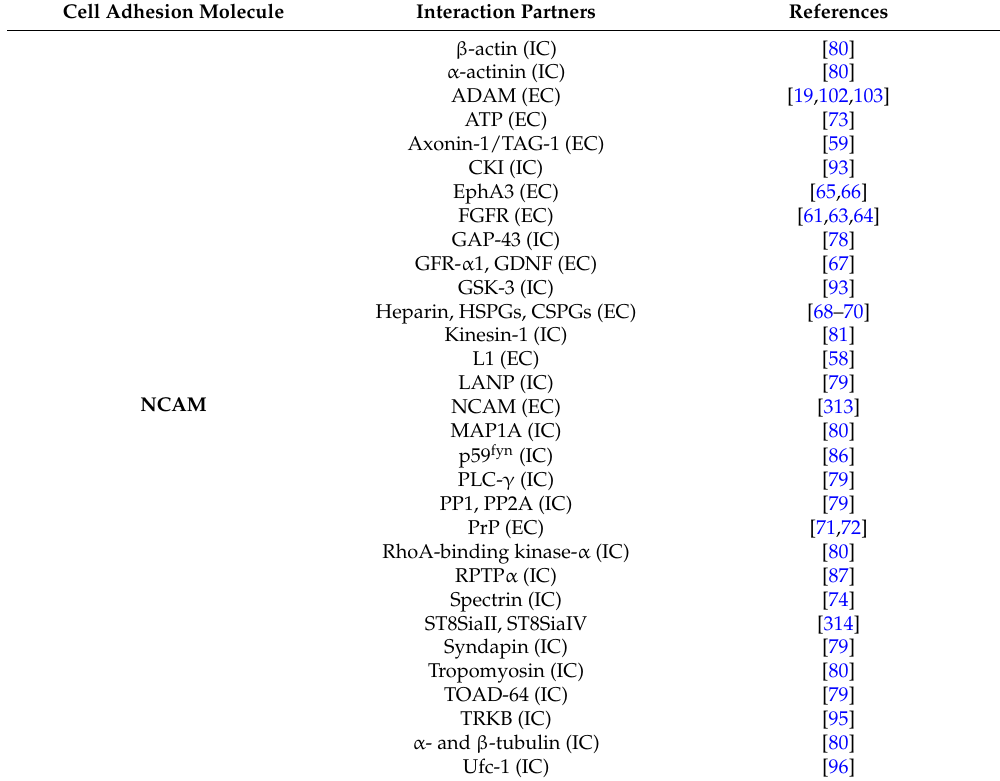
Table 2. Overview about the above mentioned interaction partners of the described cell adhesion molecules. EC, extracellular; IC